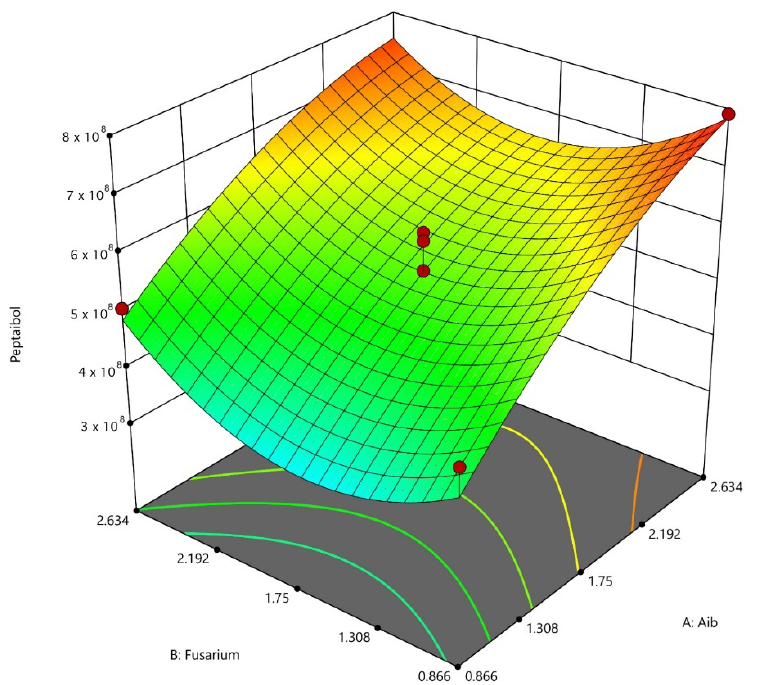
Figure 4. Surface response graph of the central composite model generated for the optimization of P aib produced in the fermentation of T. asperellum .